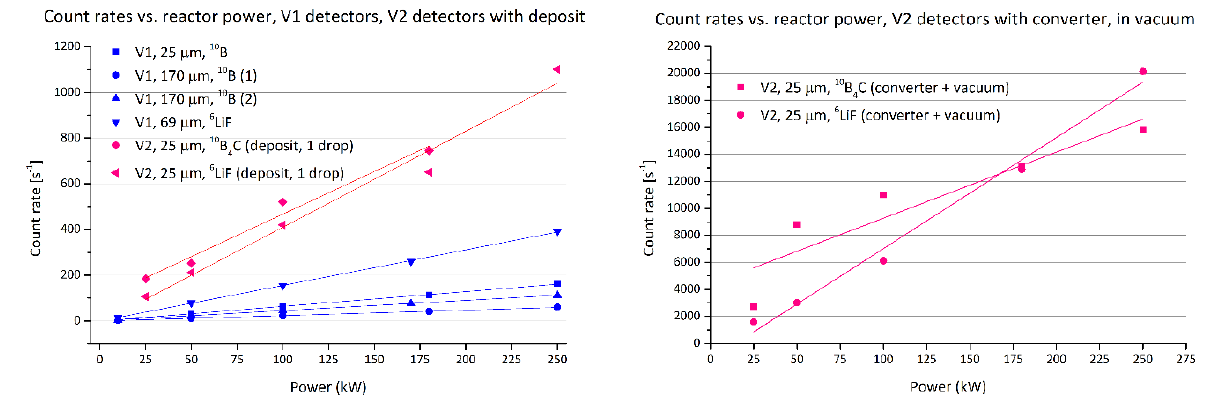
Figure 8: Registered count rates as a function of reactor power for version 1 detectors (in blue) and version 2 detectors (in pink). Left: version 1 and version 2 detectors with converter material deposited on the SBD surface. Right: version 2 detectors with separate converters, in vacuum. The straight lines are linear functions fitted to experimental